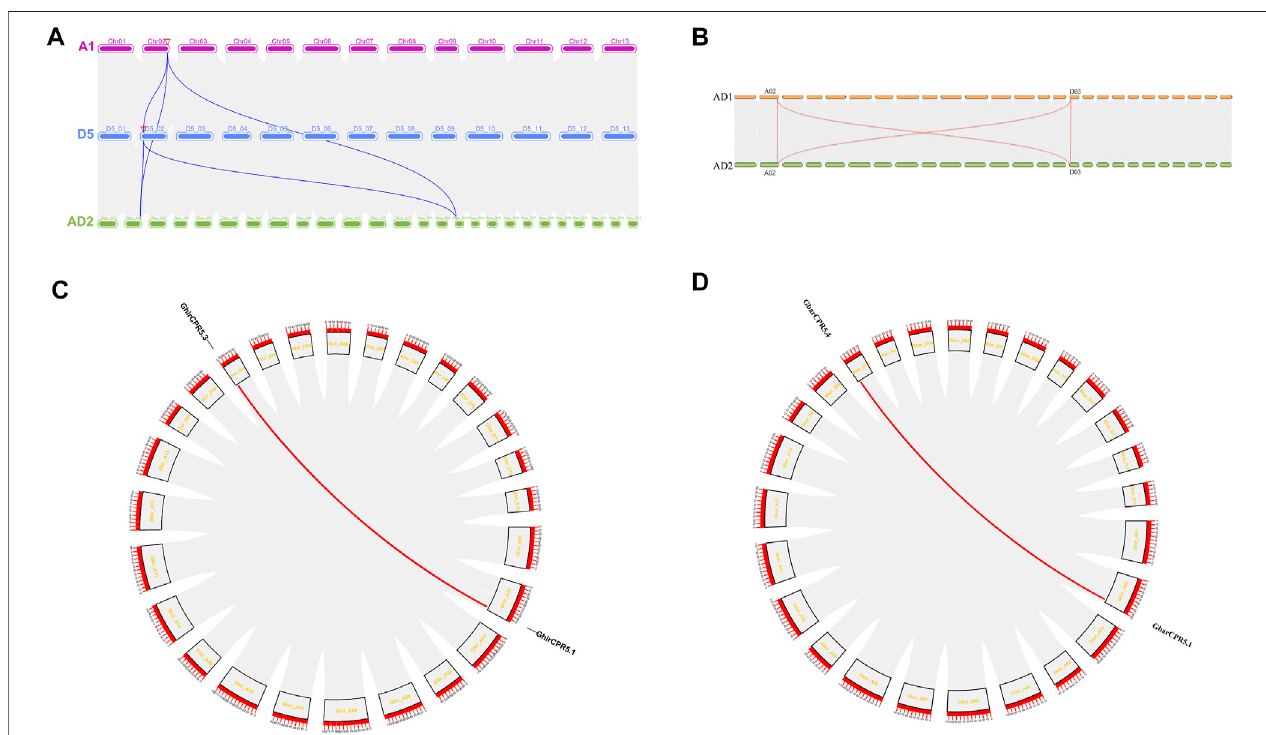
FIGURE4| Syntenic relationships among CPR5 genesin A2,D5 and AD2and AD1and AD2. (A, B) CPR5 genesareplotted against their projected complements in the fi ve species. The chromosomes of AD1 are shown as number A1-A13, and the chromosomes of D5 are shown as D2-01 to D2-13 whereas in AD2 the chromosomes were shown as Gbar A1-Gbar-A13. The grey lines indicate the collinear blocks between different species. The blue lines represent the collinear CPR5 genepairsbetweenA2,D5andAD2.Theorangelinerepresentsthecollinear CPR5 genepairsbetweenAD1andAD2. (C,D) The CPR5 collineargenepairsonA2, D5 and AD2 chromosomes. Red line represents a pair of collinear